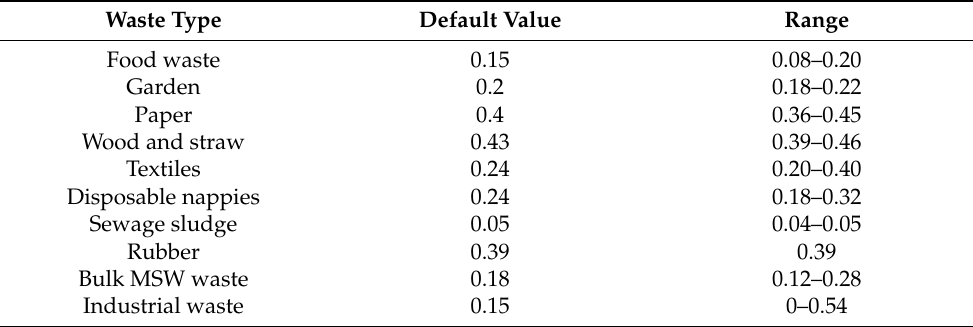
Table 7. IPCC default values and range for degradable organic carbon (DOC) content in wet waste